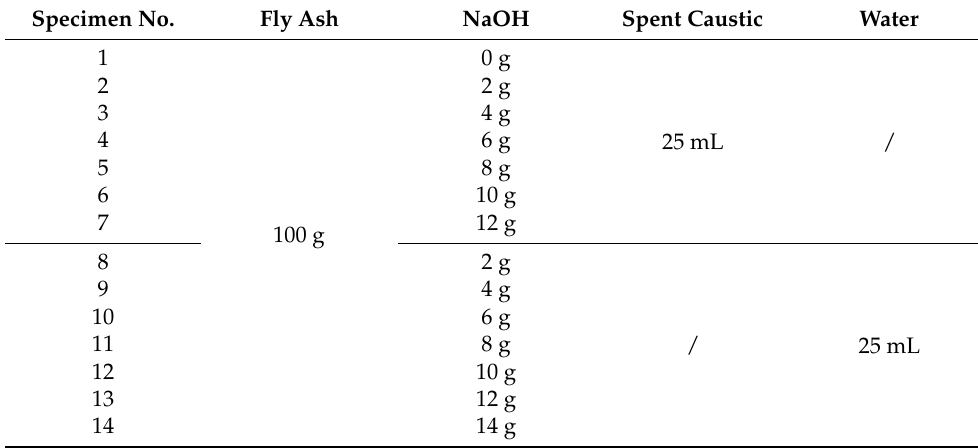
Table 2. Preparation regime of geopolymers. Specimen No. Fly Ash